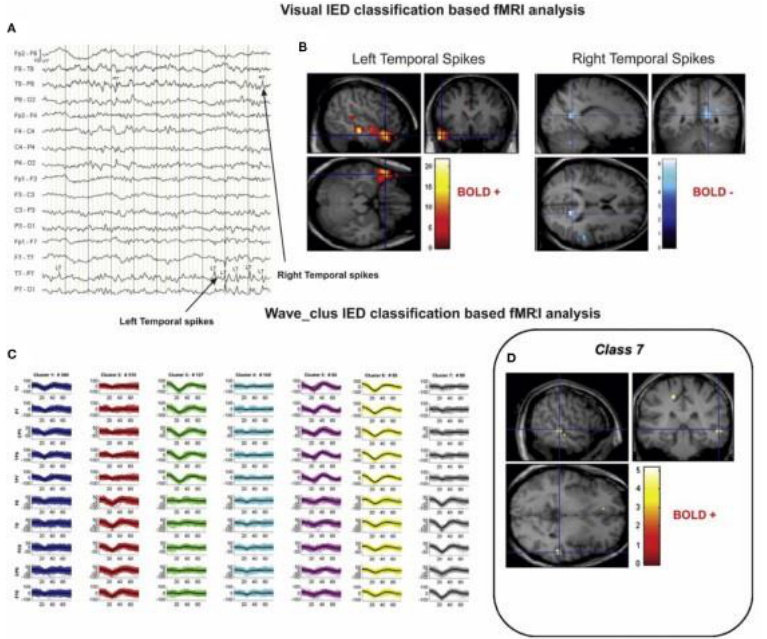
Figure 8. A sample of visual and algorithmic classification of the IEDs. ( A ) The result of visual classification from the bipolar montage (64 channels) of EEG recorded inside the scanner is performed by an expert. ( B ) The results of EEG–fMRI analysis, based on visual-IED labelling. ( C ) The seven classes identified using the algorithmic classification. ( D ) The result of EEG–fMRI analysis, associated with class 7 of the identified IEDs. All the fMRI results are overlaid on the subject’s T1-weighted image (48). Reproduced under open access license agreement CC BY-NC-ND 4.0 from Ref [106]. Copyright 2021 the authors.